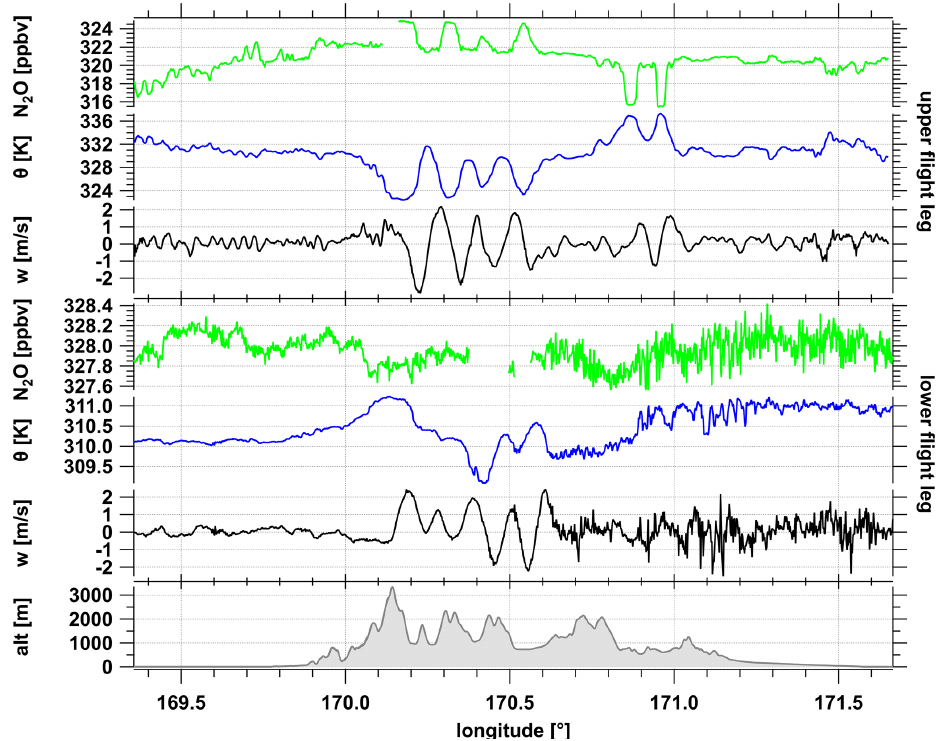
Figure 3. Cross section of the two southern stacked flight legs crossing the Southern Alps (shaded gray regions of Fig. 2) showing N 2 O (green), (cid:50) (blue) and vertical wind w (black) for the upper leg at 10.9km (top three panels) and the lower leg at 7.9km with surface elevation (bottom). Both legs are separated by 75min in time. The upper leg lies in the lower stratosphere just above the tropopause, the lower leg lies in the upper